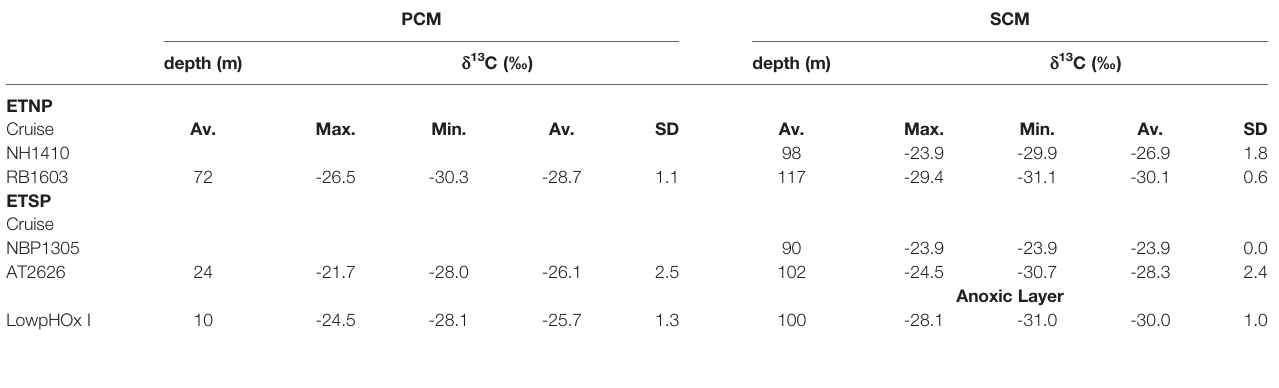
TABLE 2 | Summary of the d 13 C in the particulate organic carbon ( d 13 C – POC; ‰ ) in the primary chlorophyll maximum (PCM) and secondary chlorophyll maximum (SCM) by cruise for the Eastern Tropical North Paci fi c (ETNP) and Eastern Tropical North Paci fi c (ETSP). PCM